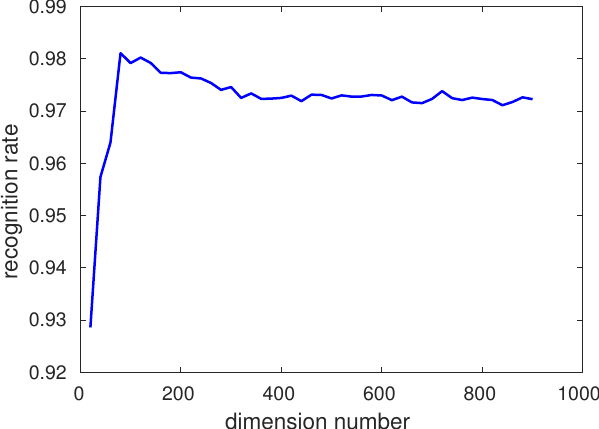
Figure 11. Relationship between Principal Component Analysis (PCA) dimension and recognition